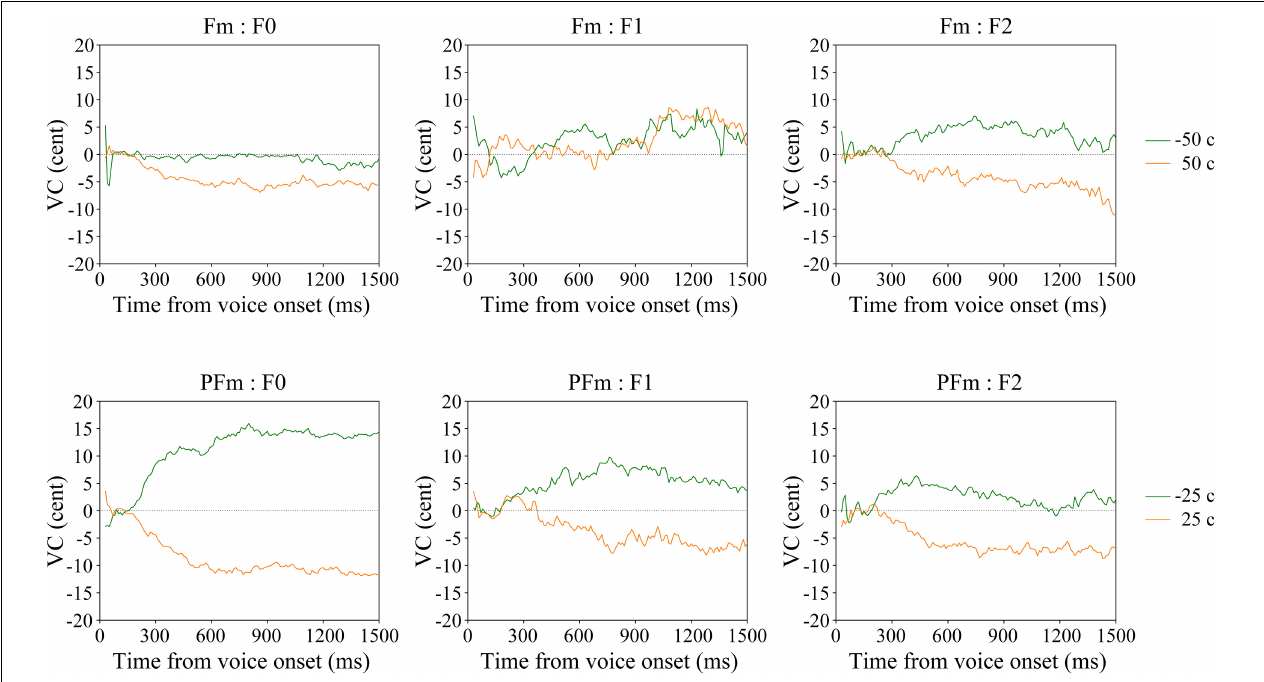
FIGURE 4 | The average VC of continuous F0, F1, and F2 in the Fm and PFm conditions for two subgroups of participants according to their subjective responses.